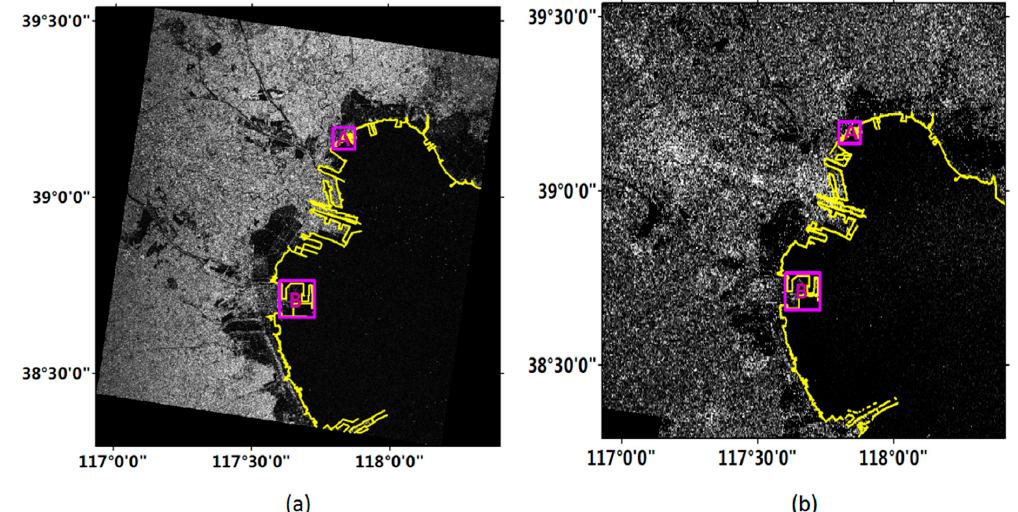
Figure 5. Coastline detection results from the improved FCM method in Bohai region. ( a ) Gaofen-3 image; ( b ) Sentinel-1 image. The boxes indicate the locations of the selected sub-regions.